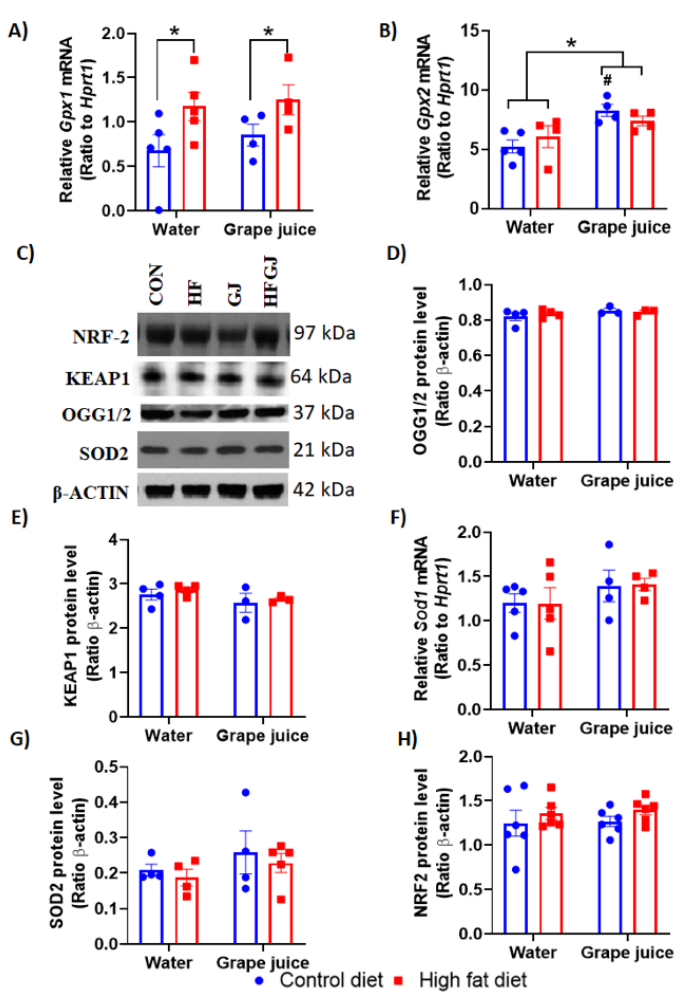
Figure 4. Quantitation of data from RT-qPCR analysis of ( A ) Gpx1, ( B ) Gpx2 and ( F ) Sod1 mRNA levels ( F ) and Western blot analysis of ( C ) OGG1 / OGG2 ( D ), Keap1 ( E ), Sod2 ( G ) and Nrf-2 ( H ) protein levels in the mammary glands of 7-week-old female o ff spring from the control or HFD fed dams which either drank tap water or grape juice. * Statistically significant di ff erence ( p ≤ 0.05) according to